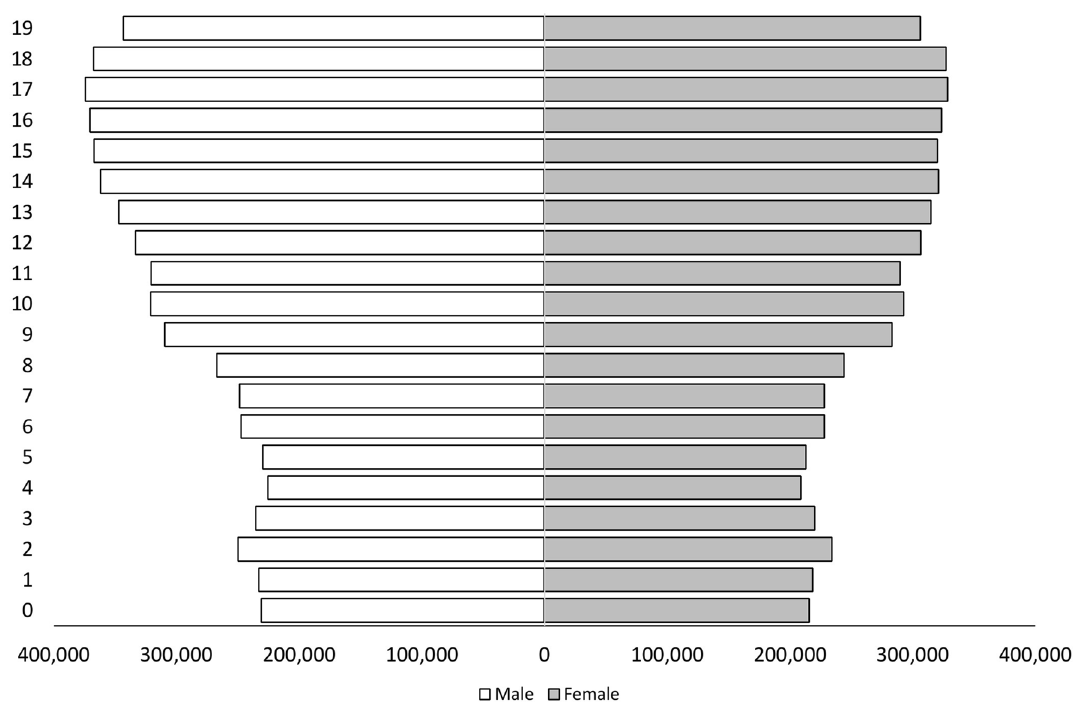
Figure 2. The population distribution by age group in 2010 in South Korea, based on Korean Statistical Information Service (KOSIS; http://kosis .kr) data. X-axis; total population according to sex, Y-axis; age in years (0–19